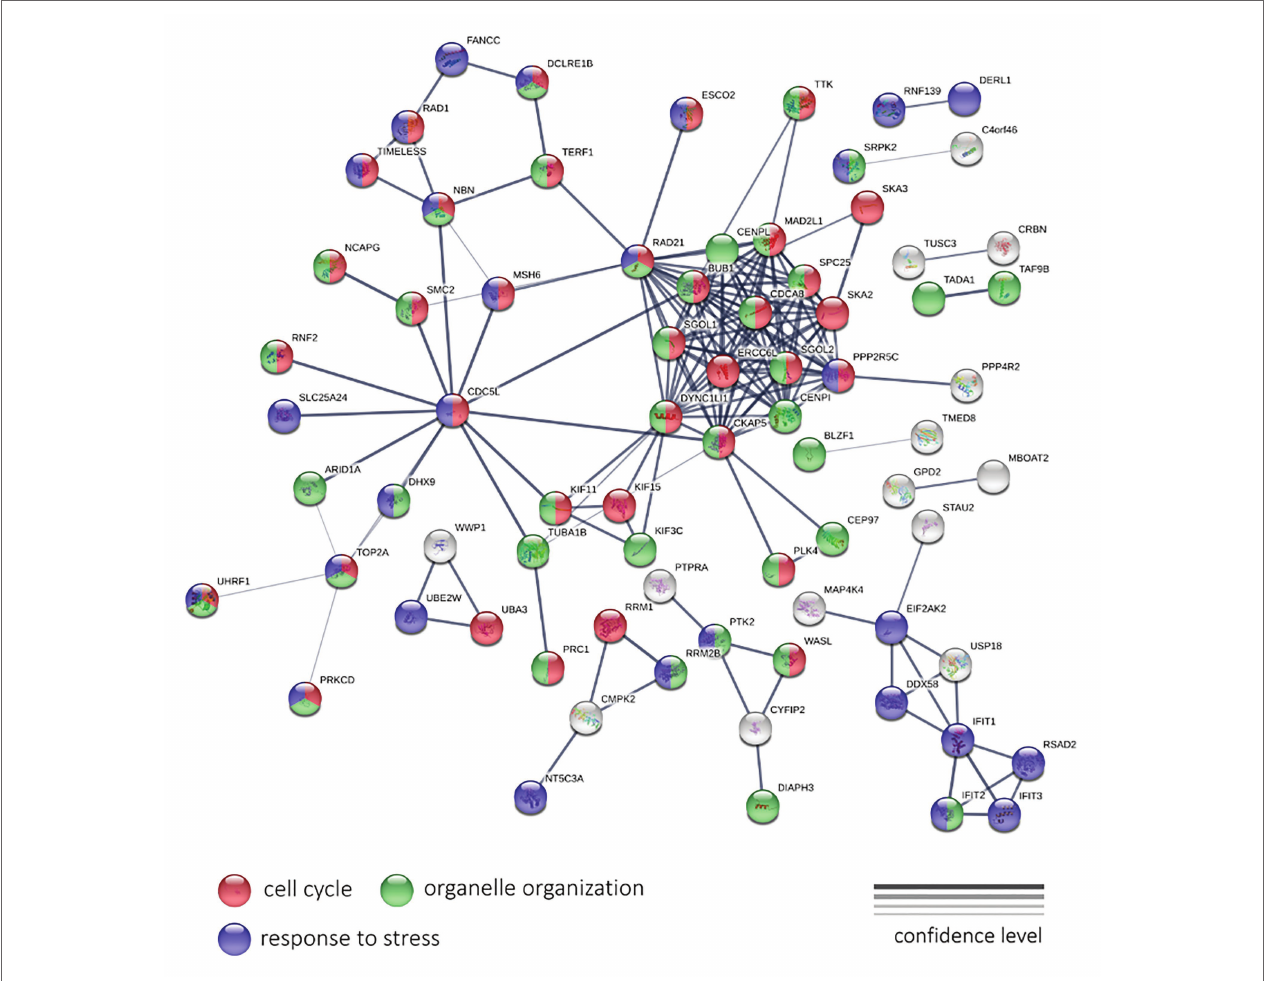
FIGURE 5 | The protein-protein interaction network of 190 genes with a significant negative expression correlation with PFS in LAPC. Circle colors indicate proteins participating in the cell cycle regulation (red), organelle organization (green), and response to stress (dark blue). If a gene does not belong to these categories, it is marked with gray. The thickness of lines indicates the reliability of evidence of the interaction between two proteins (direct or indirect experimental confirmation, predictions from homologues,